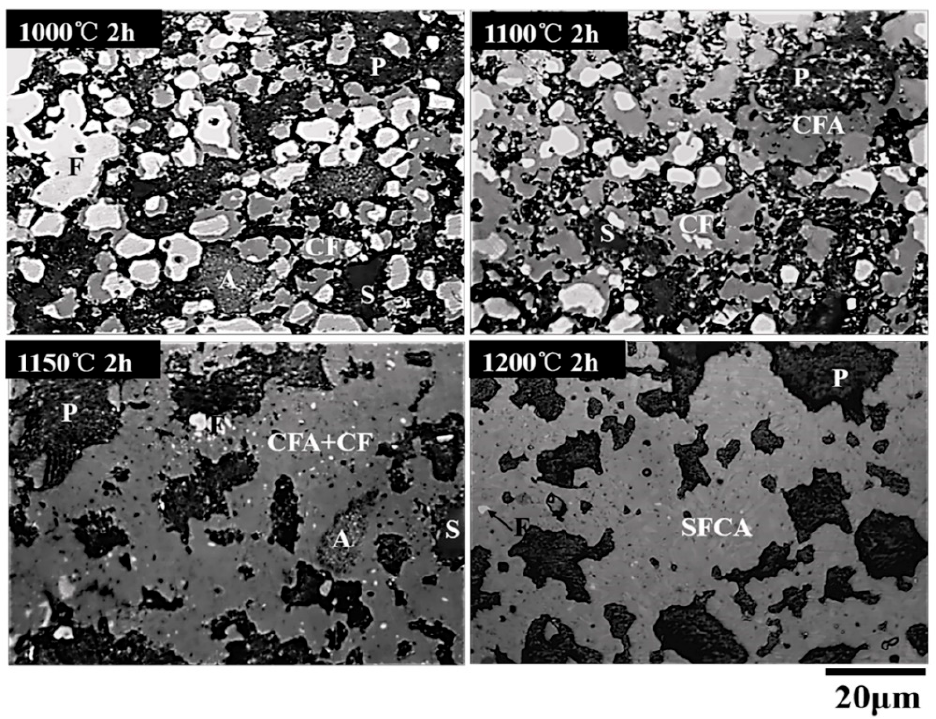
Figure 6. Microscopic photos of sample C sintered at different temperatures for 2 h. F: Fe 2 O 3 , S: SiO 2 , A: Al 2 O 3, CF: CaFe 2 O 4 , CFA: calcium iron aluminum oxide, SFCA: silico-ferrite of calcium and aluminum, P = pore.